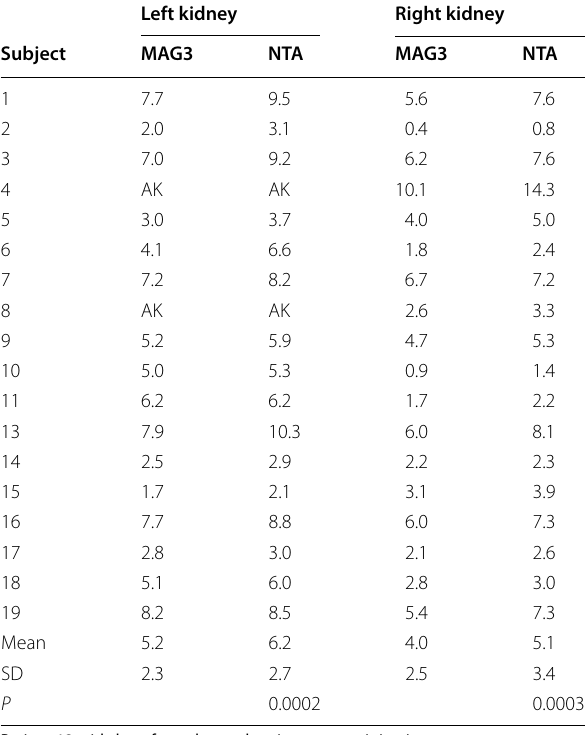
Table 2 Kidney to background ratios of NTA and MAG3